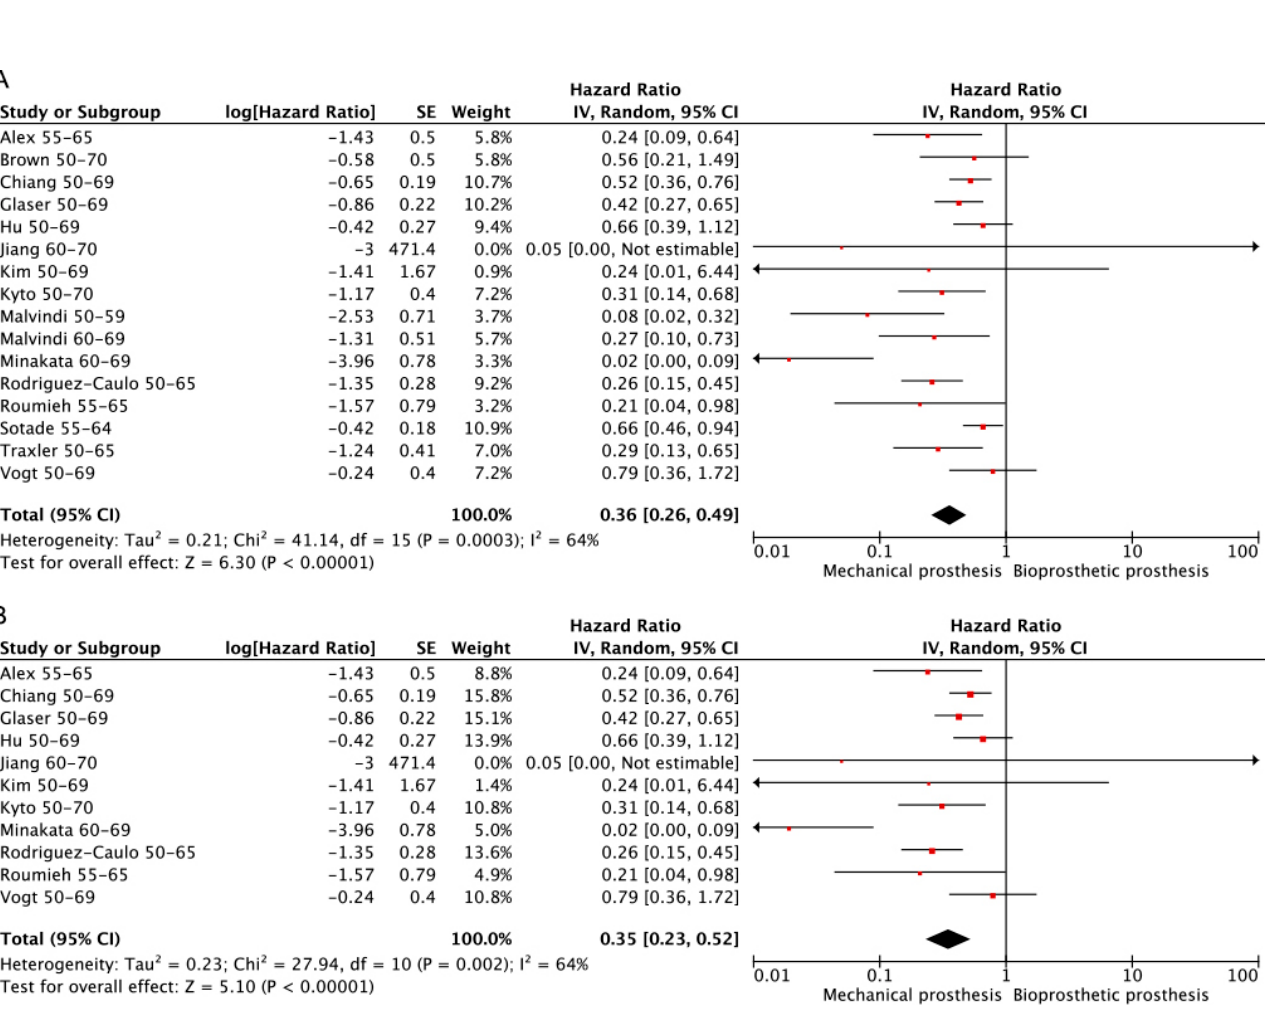
Figure 5. Meta-analysis for freedom from reoperation. ( A ) Bioprosthetic vs. mechanical. ( B ) Biopros- thetic vs. mechanical (RCT or PSM).